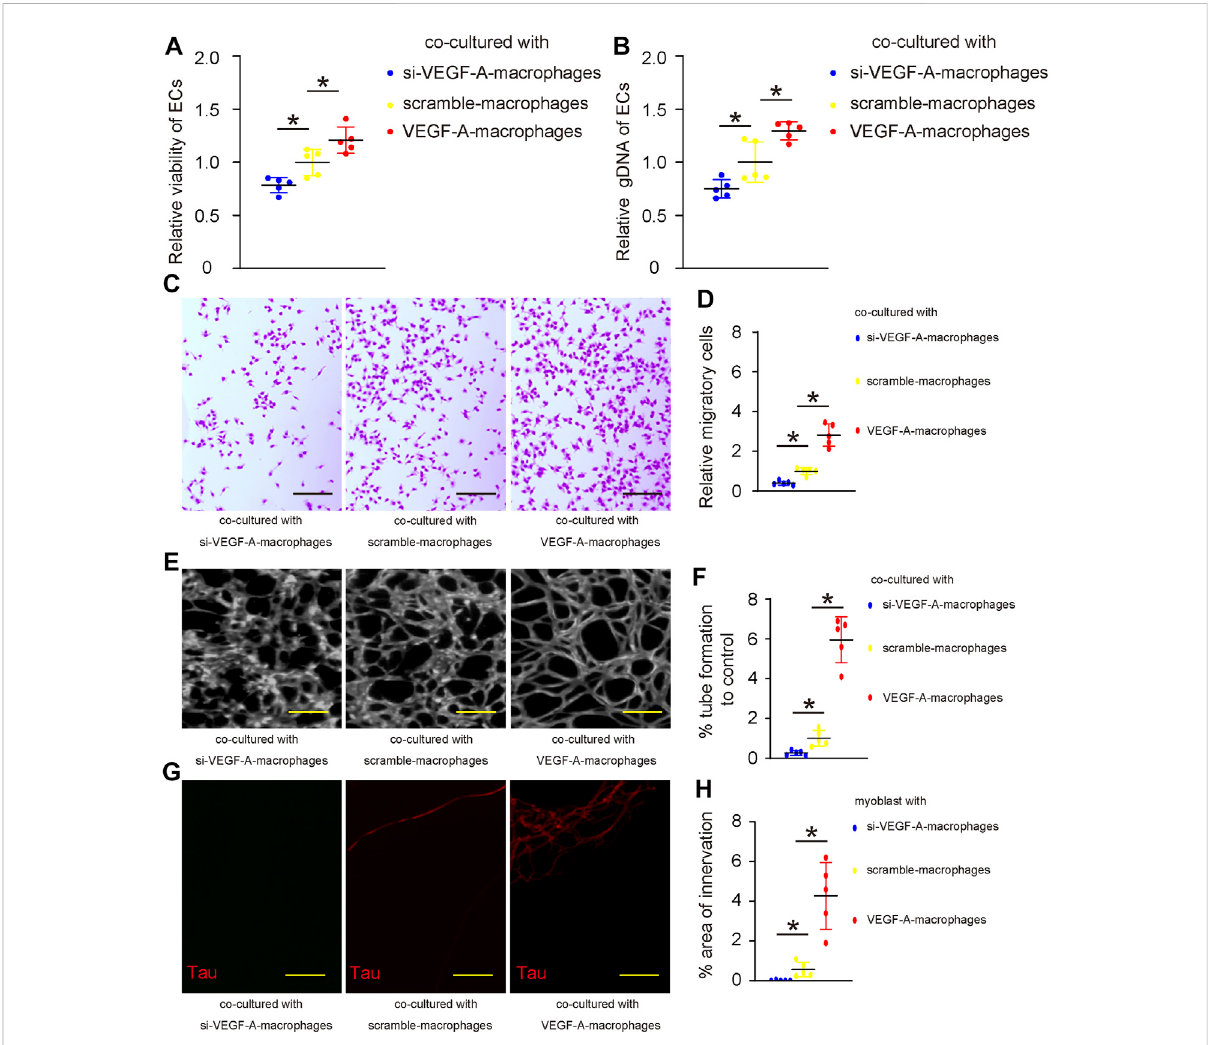
FIGURE 5 VEGF-A in macrophages promotes angiogenesis and innervation in vitro . (A – F) VEGF-A, scramble, or si-VEGF-A virus-transduced mouse IL-4-primed BMDM were co-cultured with mouse endothelial cells (ECs). (A – B) The growth of ECs was analyzed by a CCK-8 assay (A) together with quanti fi cation of total genomic DNA content (gDNA) on them (B) . (C – D) The migratory potential of ECs was assessed, shown by representative images (C) and by quanti fi cation (D) . (E – F) The angiogenetic potential of ECs was assessed in a tube formation assay, shown by representative images (E) and by quanti fi cation (F) . (G,H) The effects of VEGF-A in macrophages on innervation was assessed in a micro fl uidic chamber system that allows induction of innervation of embryonic spine cord explant into the co-cultured area for macrophages and skeletal myocytes, shown by representative images for Tau staining in the co-culture area (G) and by quanti fi cation (H) . * p < 0.05. N = 5. Scale bars were 100